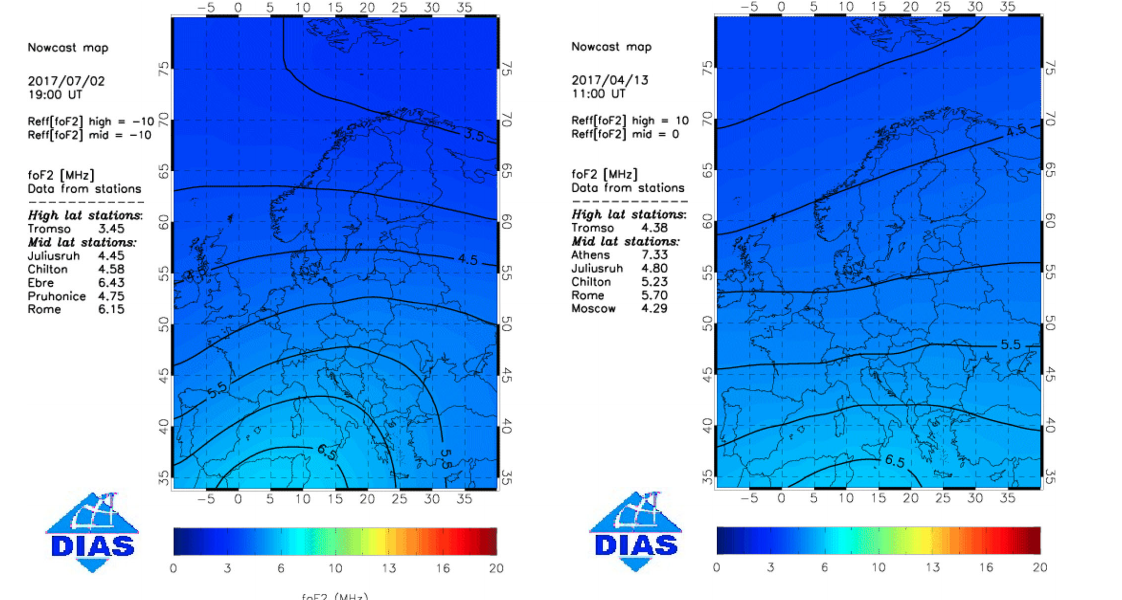
Figure 11. Examples of hourly fo F2 nowcast maps predicted by SIRM and SIRMUP in July and April 2017 for DIAS (http://www.iono. noa.gr/Dias/, last access: 15 May